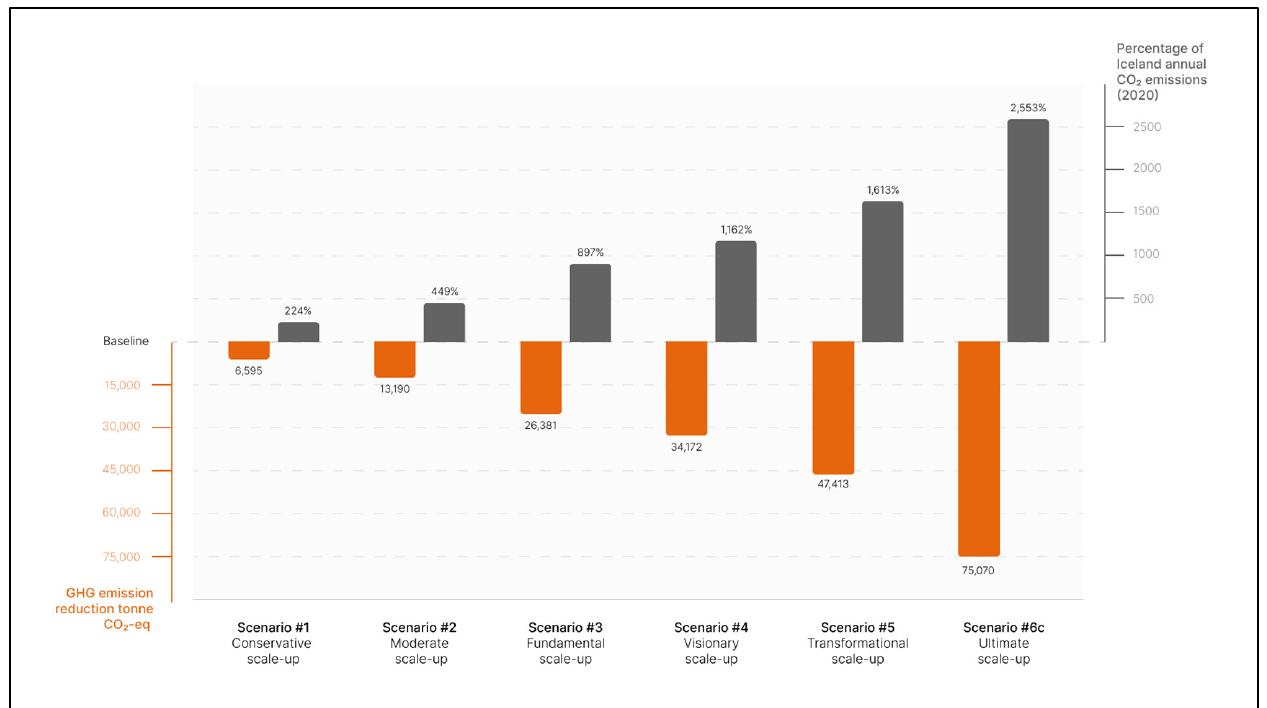
Figure 5. Summary of global GHG emissions reduction potential related to the six Spirulina biomass production scenarios as calculated in this study in CO 2 -eq, including percentage of Iceland’s annual emissions in CO 2 .